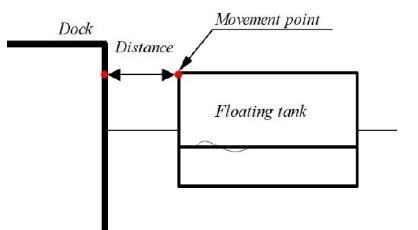
Water 2021 , 13 , x FOR PEER REVIEW Figure 6. Distance between floating tank and dock. Figure 6. Distance between floating tank and dock.